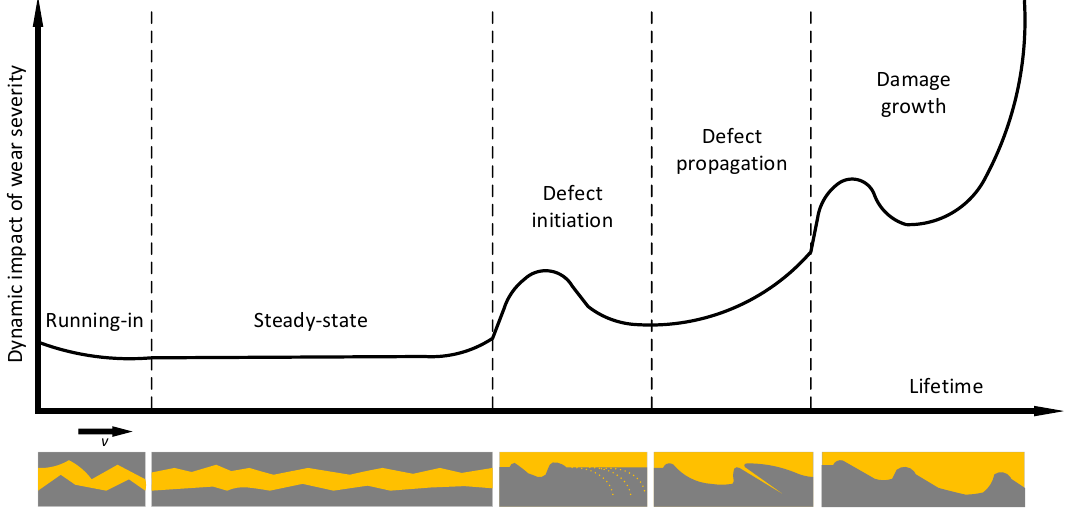
Figure 15. The descriptive model proposed by El-Thalji and Jantunen.